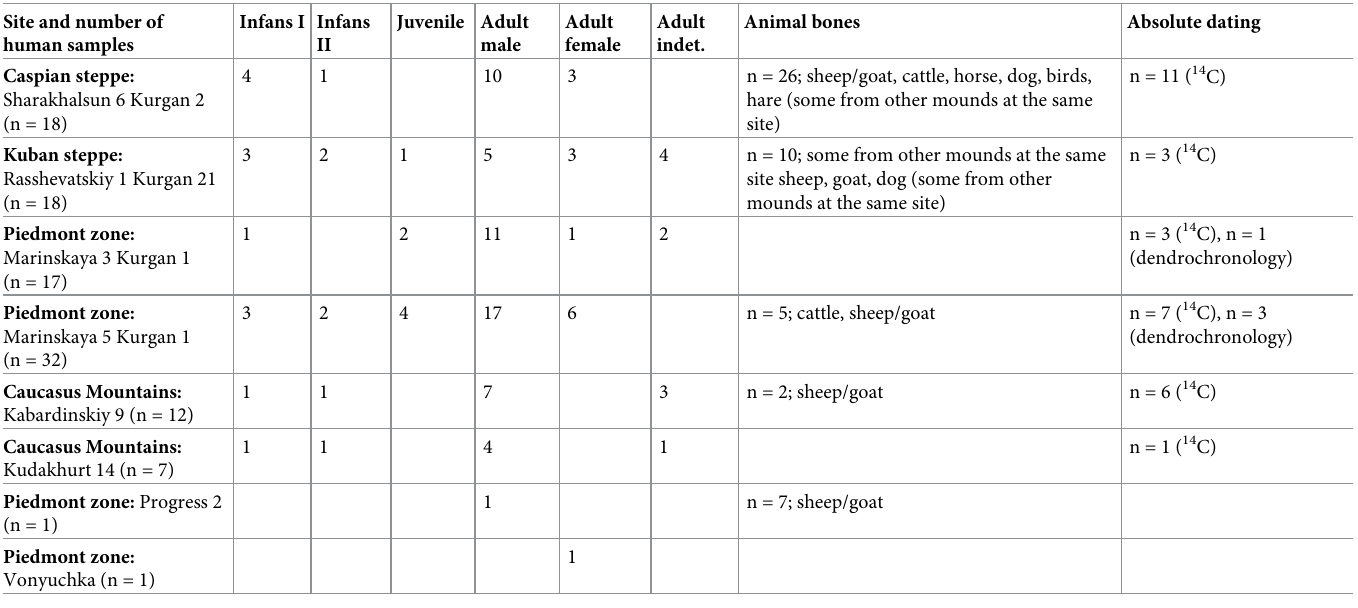
Table 2. Investigated sites and corresponding number of sampled human individuals grouped according to age classes and sex of adult individuals, number of ani- mal samples, and number of samples for radiocarbon dating and dendrochronology. Site and number of human